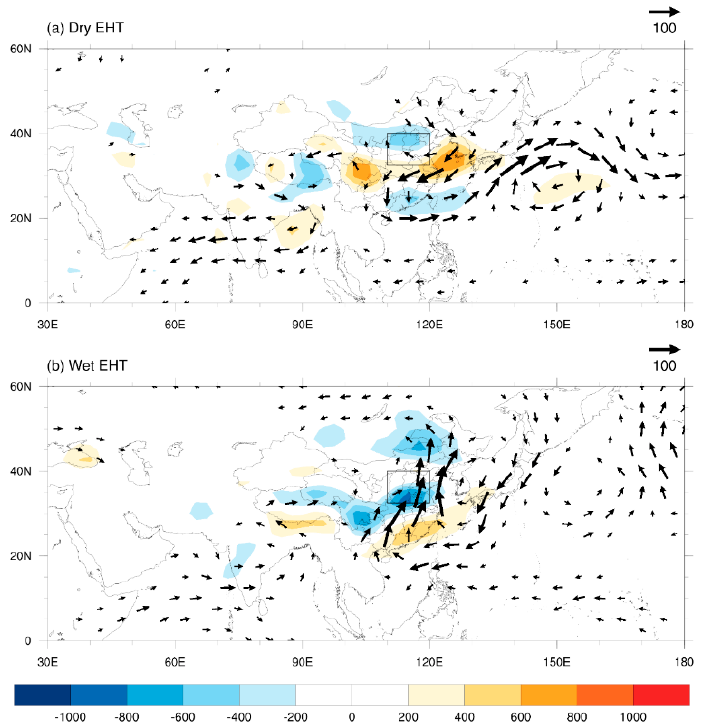
Figure 4. Composite anomalies of the whole layer (from 300 hPa to 1000 hPa) water vapor flux (vector; unit: 10 2 kg/(m · s)) and its divergence (shadings; 10 − 5 kg/(m 2 · s)) in ( a ) dry and ( b ) wet EHT days in MLRYR.